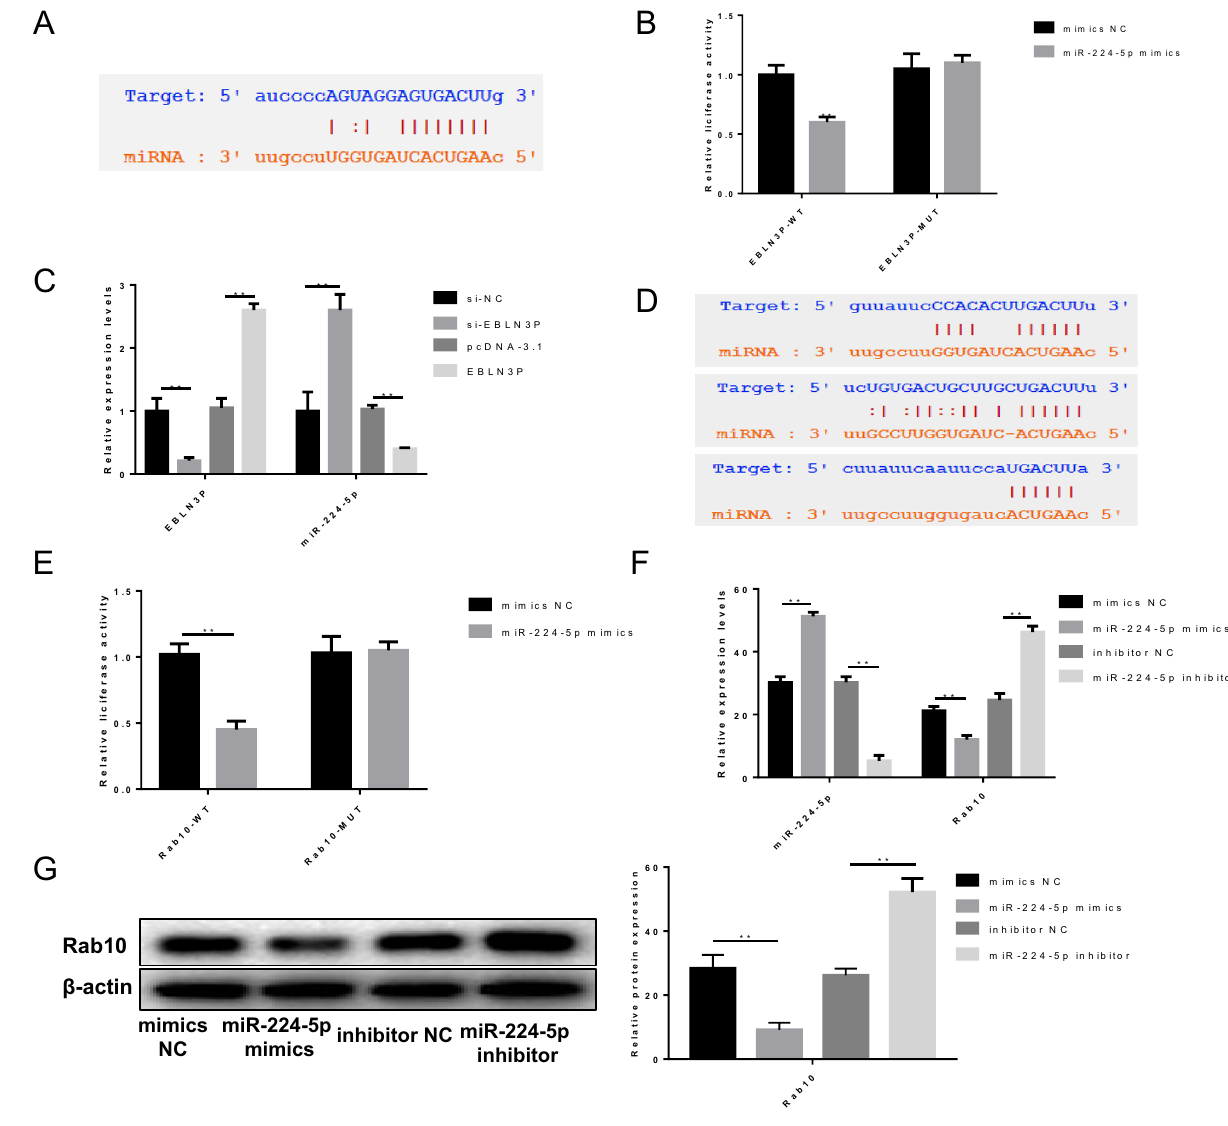
Figure 2. The interaction between EBLN3P, miR-224 and Rab10. ( A ) Bioinformatics analysis revealed that EBLN3P can directly interact with miR-224-5p. ( B ) Dual-luciferase reporter assays were performed to verify the effect of miR-224-5p on the luciferase signal of reporters containing EBLN3P. 143B cells were transfected with EBLN3P targeted shRNA (si-EBLN3P), negative control shRNA (si-NC), pcDNA3.1-EBLN3P overexpression vector (pcDNA-EBLN3P) and blank vector plasmid (pcDNA-3.1). ( C ) The expression level of EBLN3P and miR-224-5p was assessed via reverse transcription-quantitative PCR analysis. ( D ) Bioinformatics and luciferase assay revealed that miR-224-5p can directly bind to the Rab10 3 ′ -UTR region. ( E ) The miR-224-5p mimics and luciferase reporter plasmids with wild-type or mutant Rab10 3 ′ -UTR were co-transfected into 143B cells. Dual luciferase reporter gene assay was performed to verify the direct binding between miR-224-5p and Rab10. ( F ) 143B cells were transfected with mimics NC, miR-224-5p mimics, inhibitor NC, miR-224-5p inhibitor, and then reverse transcription-quantitative PCR was undertaken to evaluate the relative expression levels of miR-224-5p and Rab10. ( G ) Western blot analysis validated that overexpression of miR-224-5p significantly reduced Rab10